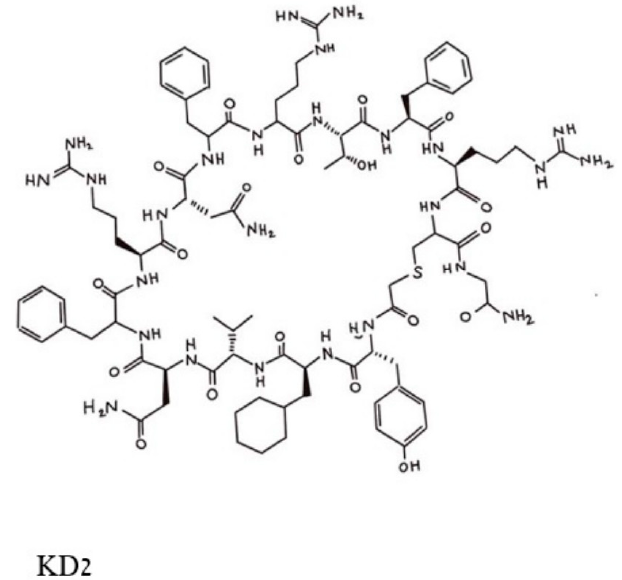
Figure 4. Pincus et al. Structure of the cyclic peptide, KD2, that blocks the activation of the G12D-RAS-p21-GTP complex. The Thr 10 residue whose side chain -OH group makes contact with the Asp 12 residue is in the top middle of the figure and can be identified by the -OH in this area.